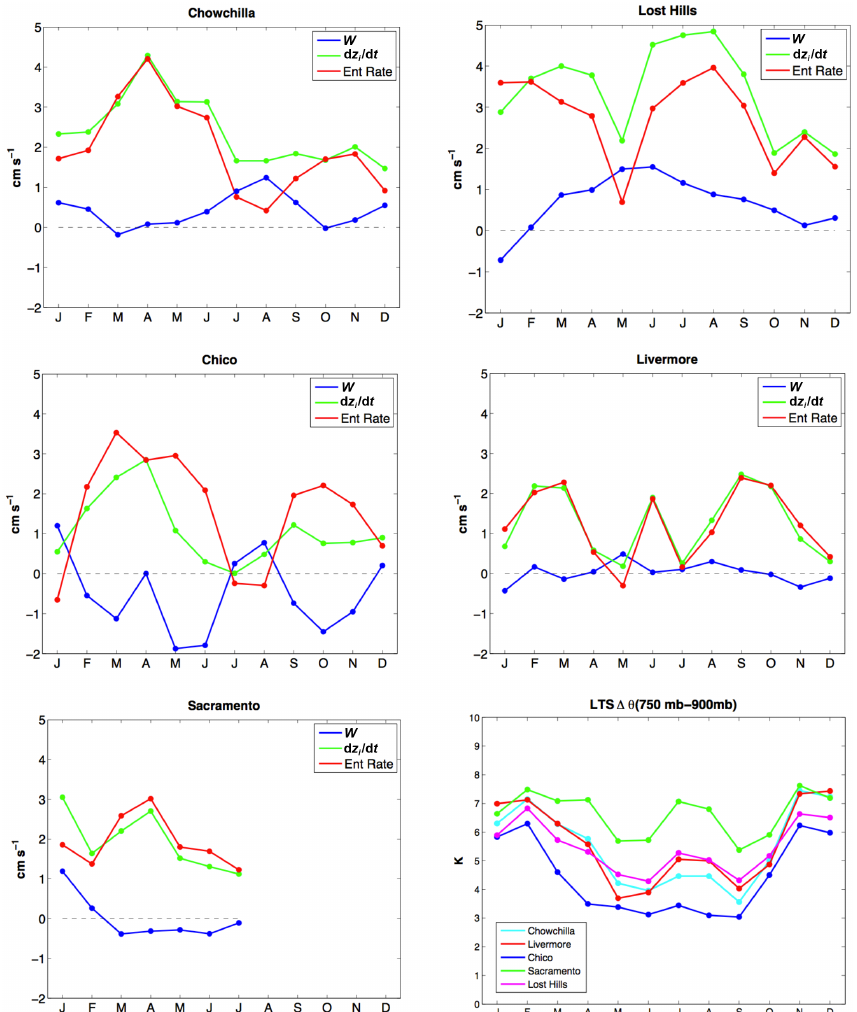
Figure 7. Observed monthly average ABL growth rates (d z i / d t , green lines) from the RASS network across the Central Valley described in Bianco et al. (2011) from the entire year of 2008. The mean vertical wind from the NCEP NARR data set is included (blue lines) to yield estimates of entrainment (red lines). The lower right panel depicts the lower tropospheric stability (LTS) defined from the reanalysis data as the difference in potential temperatures at 750 and 900hPa